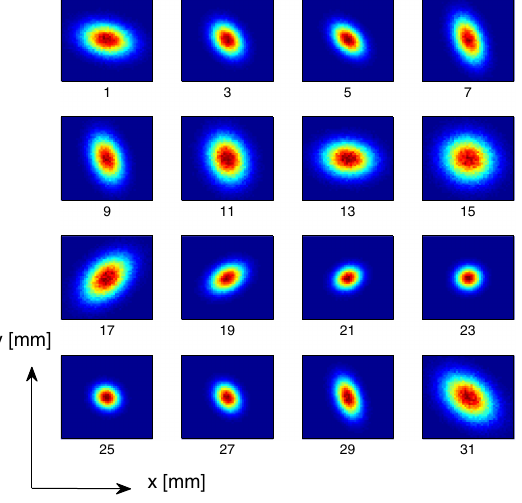
FIG. 5. Simulated measurement example: beam images for every other scan step. See also Fig. 4.